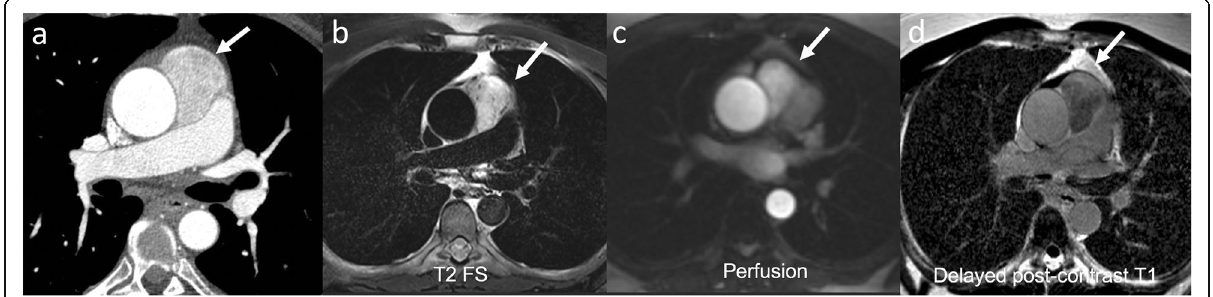
wash out on delayed images. Pathology confirmed